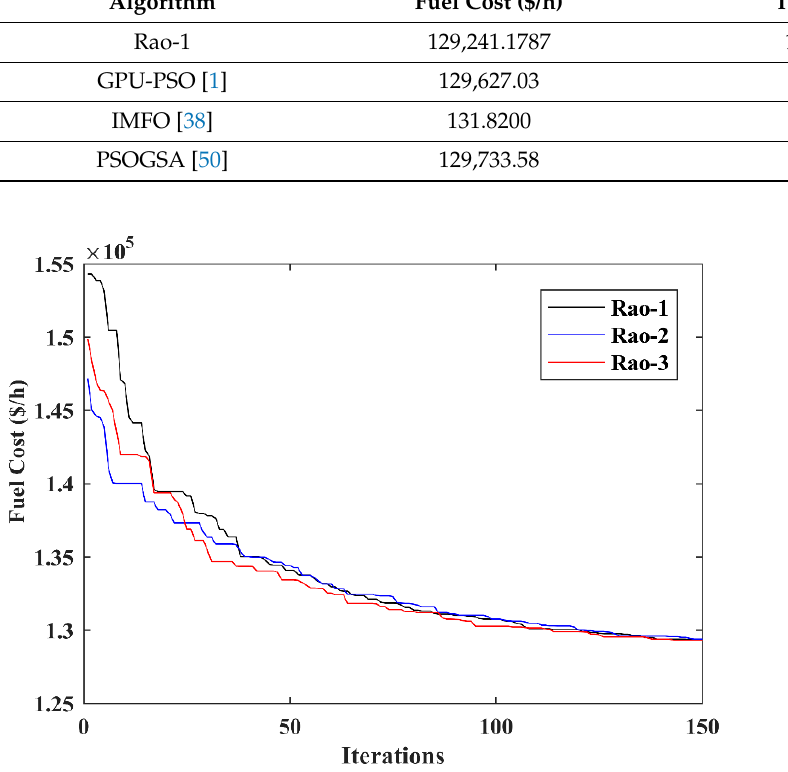
Figure 9. Fuel cost convergence characteristic of Rao algorithms for Case 11.